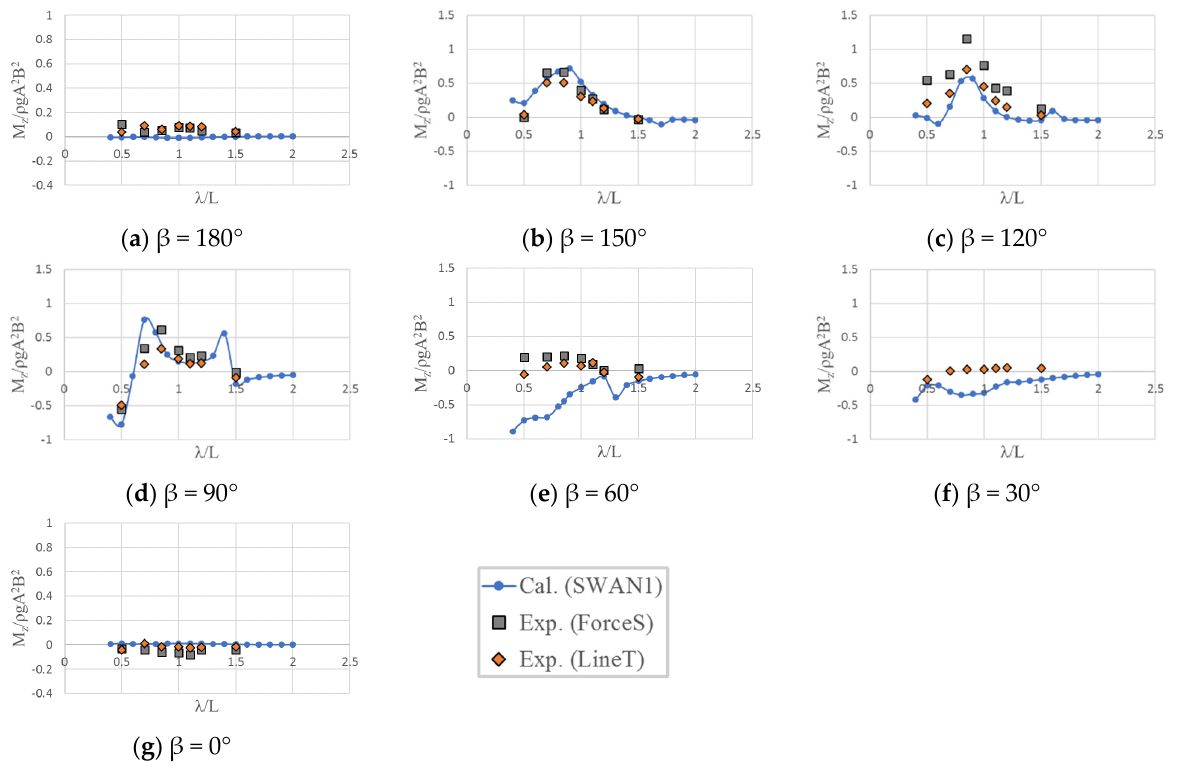
Figure 16. Yaw drift moment on KVLCC2: V = 6 knots, H/L = 1/50.